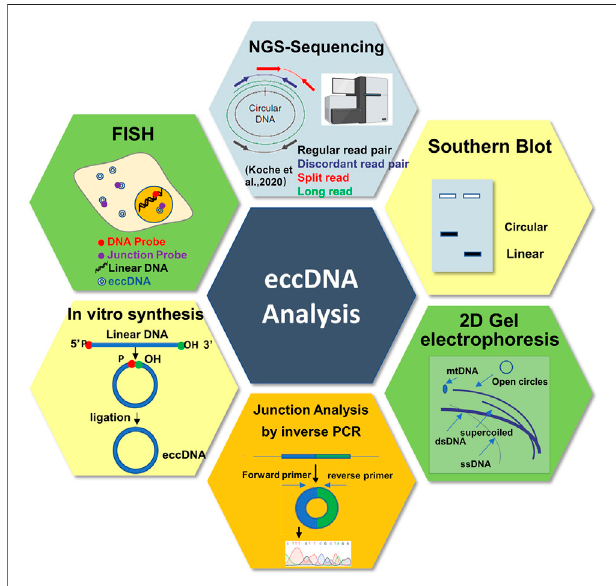
FIGURE 4 | Schematic representation of the different approaches and tools to study circular